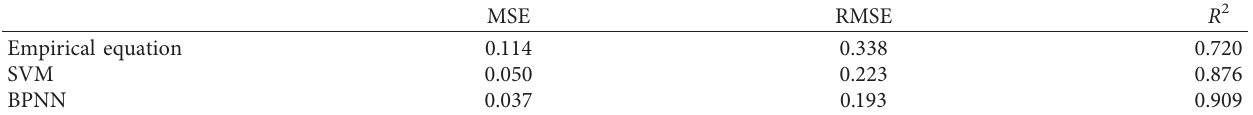
Figure 15: Distribution of the errors from machine learning methods. (a) Training. (b) Testing. Table 8: Evaluation parameters of machine learning methods and empirical